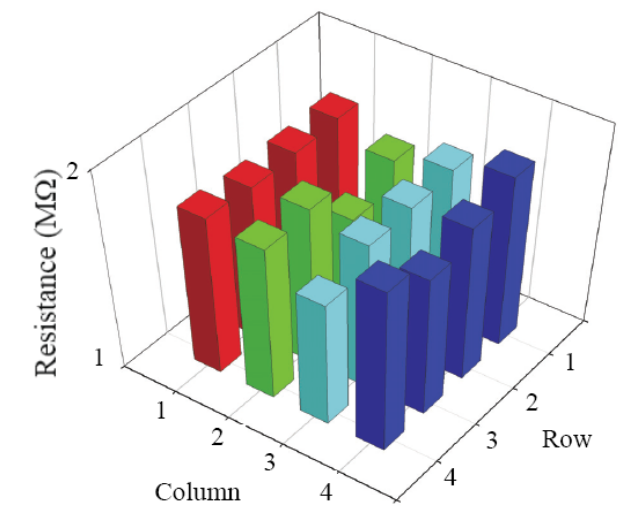
Figure 10. A 4  4 resistance map of the fabricated sensor